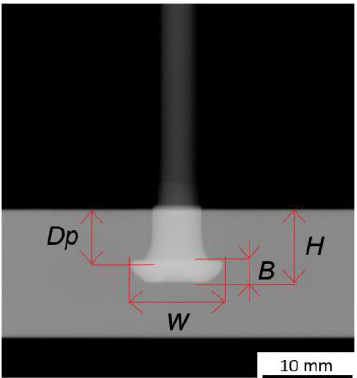
Figure 2. Example of X-ray tomography measurements for the joint formation analysis.